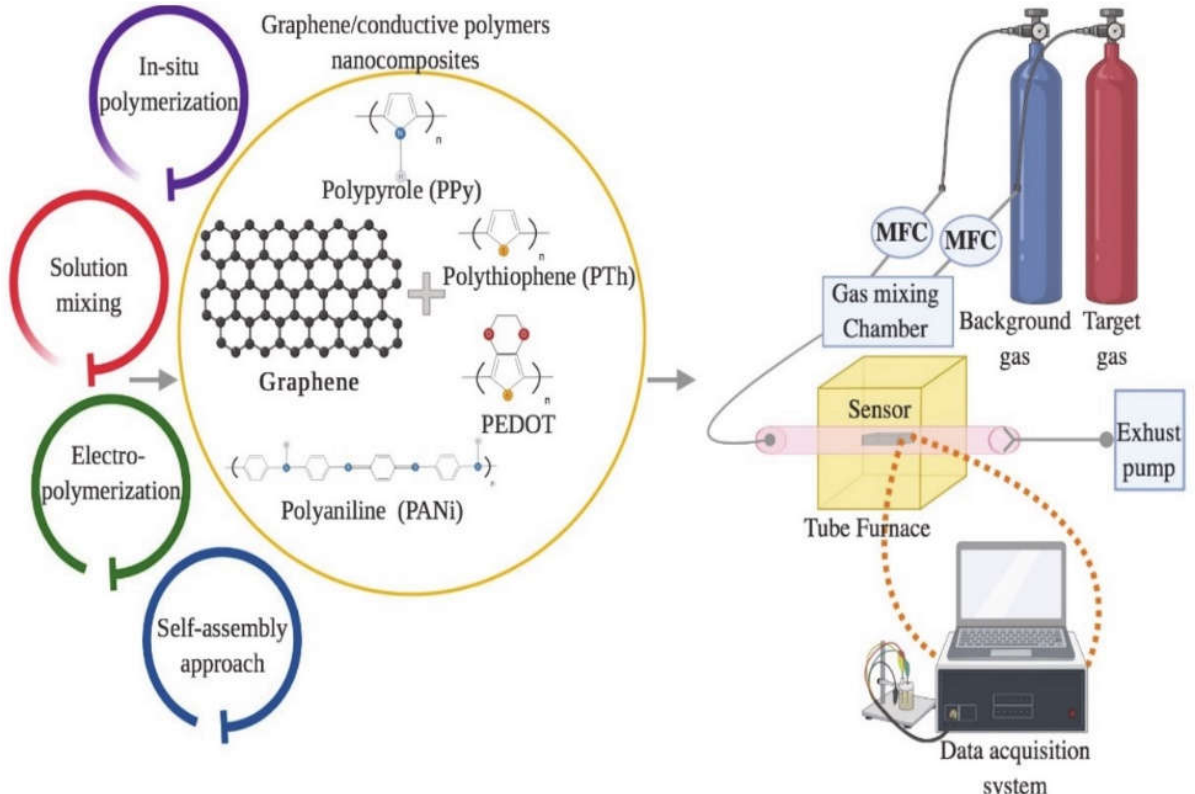
Figure 5. Schematic diagram for the preparation of graphene/conductive polymer composites and their applications for gas sensing. Adapted with permission from [82]. Copyright MDPI 2020.